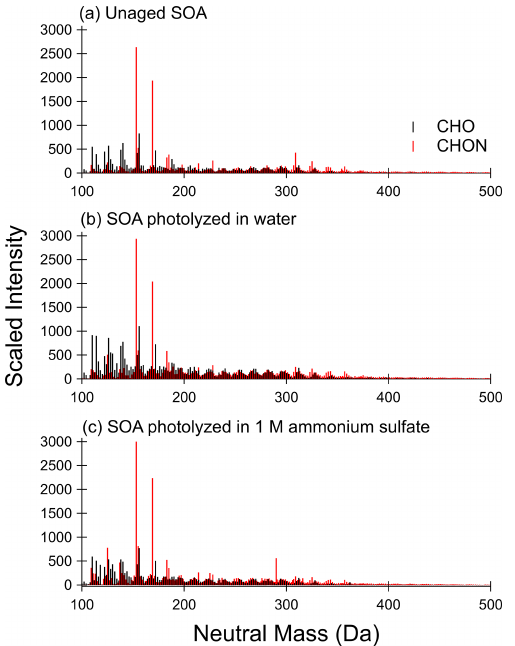
Figure 4. Mass spectra for (a) unaged SOA sample, (b) SOA sam- ple photolyzed 5h in water, and (c) SOA sample photolyzed 5h in 1M ammonium sulfate from Filter 4. CHON compounds are shown in red, and CHO compounds are shown in black. Signal is scaled to approximate pre-photolysis mass concentration of SOA in mass spectrometry samples. Control (dark aged) samples are shown in Fig.